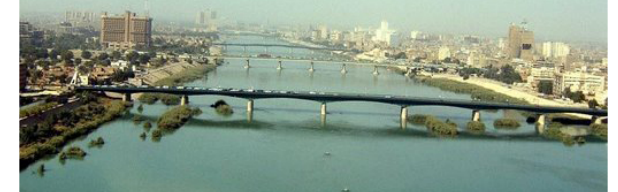
Fig. 6. Small growing islands at Jumhuriyah Bridge location.